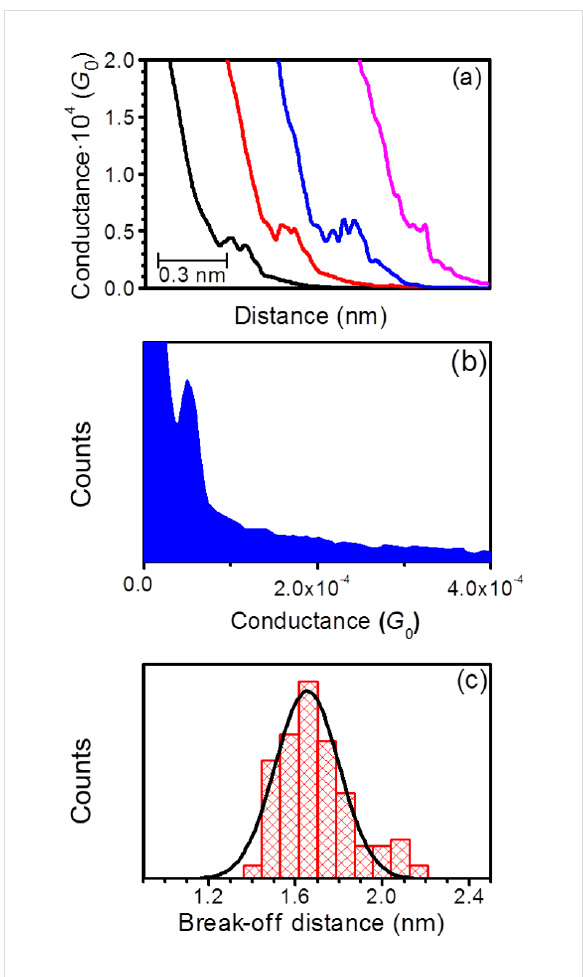
Figure 9: (a) Typical conductance traces of 1 using the I ( s ) method. The curves have been shifted horizontally for clarity. (b) Conductance histogram built by adding together all the points of 300 conductance traces that show discernible plateaus such as those displayed in (a). (c) Break-off distance histogram. Conductance data are presented in units of the conductance quantum ( G 0 = 2 e 2 / h = 77.4 μ S), U t = − 0.3 V.